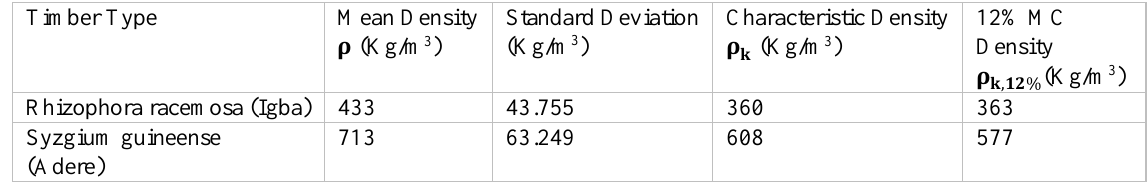
Mean and Characteristic density of Timbers.